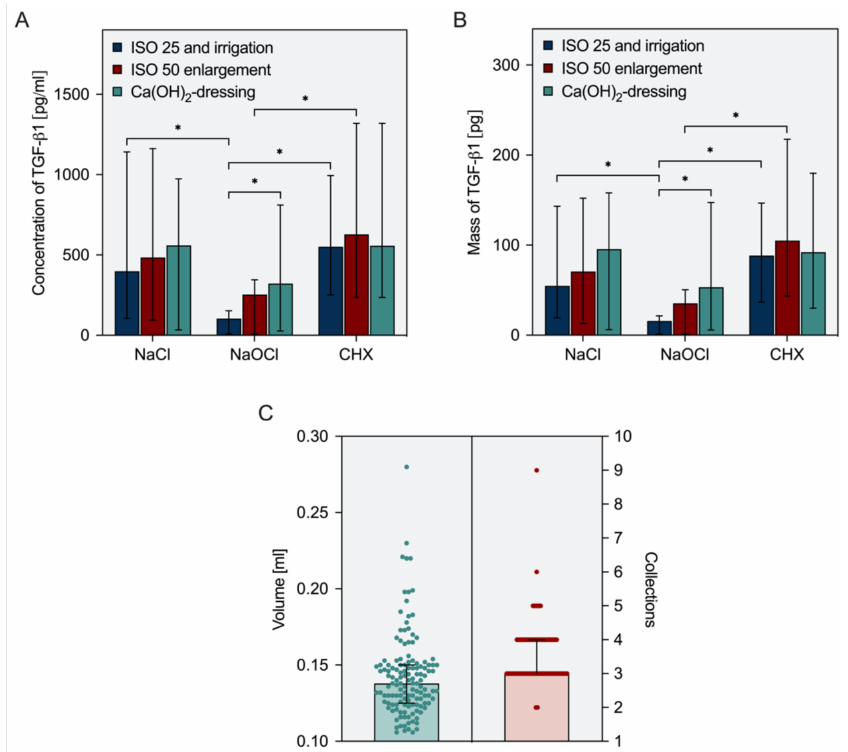
Figure 2. Collection of growth factors from root canals in an ex vivo model. Release of TGF- β 1 depending on irrigant solution after a 3-step-protocol including initial preparation, root canal enlargement, and the use of an intracanal dressing. ( A ) Concentration and ( B ) absolute mass of soluble TGF- β 1 in EDTA collected from root canals after ultrasonic activation ( n = 12). ( C ) Retrieved volumes of EDTA and number of collections necessary to obtain a minimum total volume of 100 µ L ( n = 36). Depicted are median values and 25–75% percentiles (column and error bars) as well as single measurements (points). Width of distribution of points proportionate to the number of points. Asterisks indicate statistical differences between